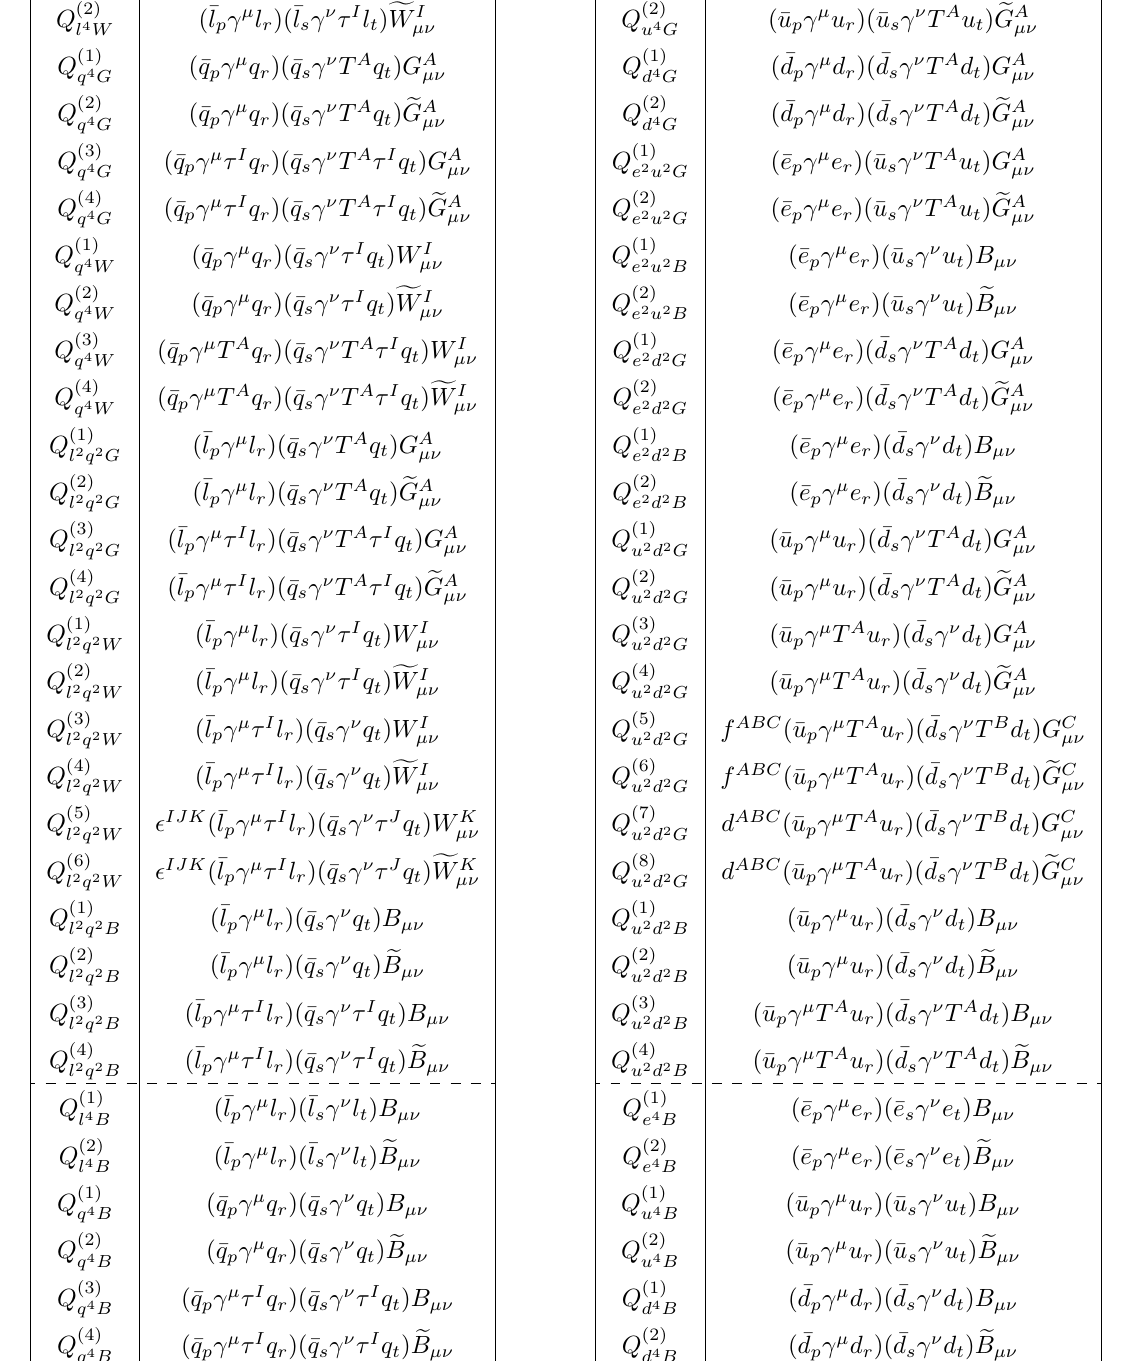
Table 12 . The dimension-eight operators in the SMEFT of class-19 with (cid:12)eld content JJX with J = ((cid:22) LL ) or ( (cid:22) RR ). The subscripts p; r; s; t are weak-eigenstate indices. Operators below the dashed lines vanish when there is only one generation of